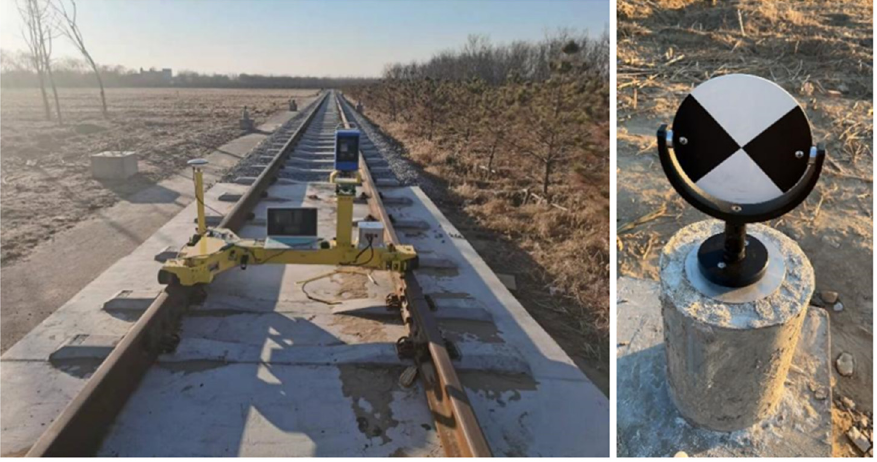
Figure 18. Test site ( left ) and target photos ( right ).